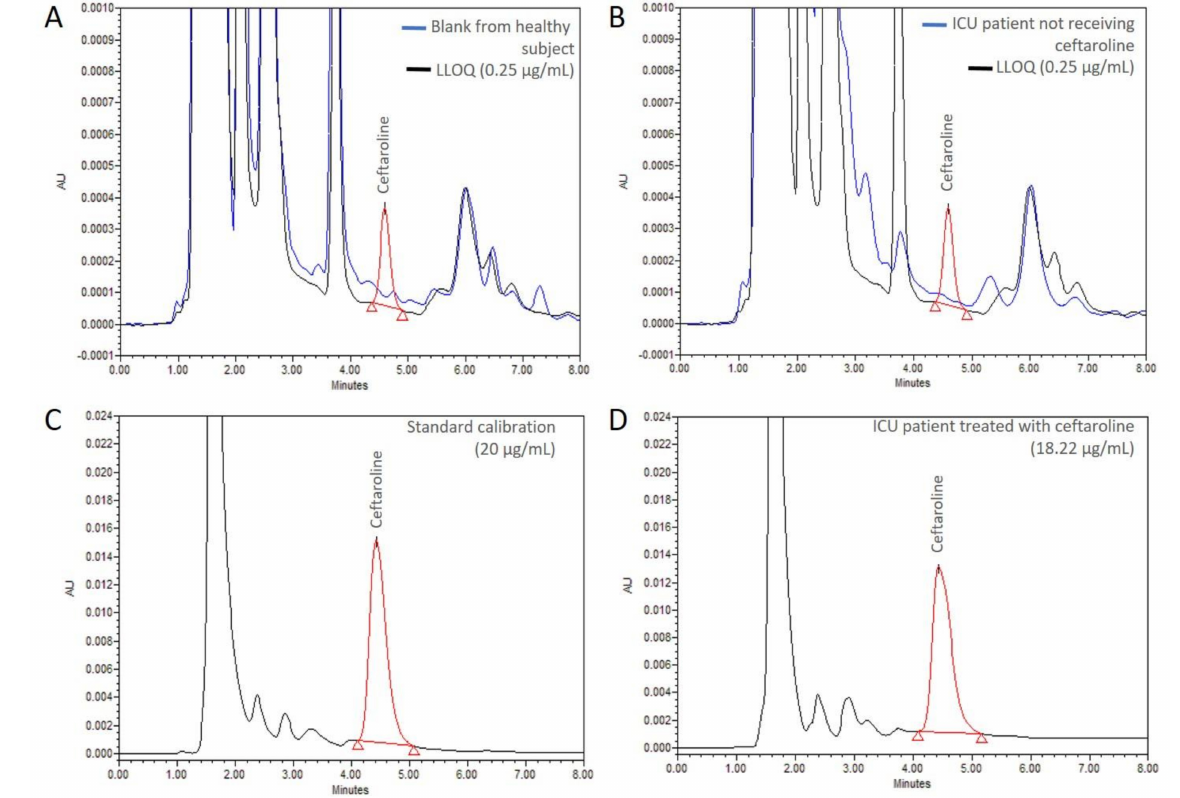
Figure 2. Representative chromatograms. ( A ) Blank sample from a healthy subject and the LLOQ. ( B ) Blank sample from an ICU patient not treated with ceftaroline and the LLOQ. ( C ) Standard calibration sample (20 µ g/mL). ( D ) Sample of an ICU patient treated with ceftaroline (18.22 µ g/mL). ICU: intensive care unit. Table 4. Intra- and inter-day precision and accuracy of the HPLC assay for ceftaroline in plasma. Nominal Concentration ( µ